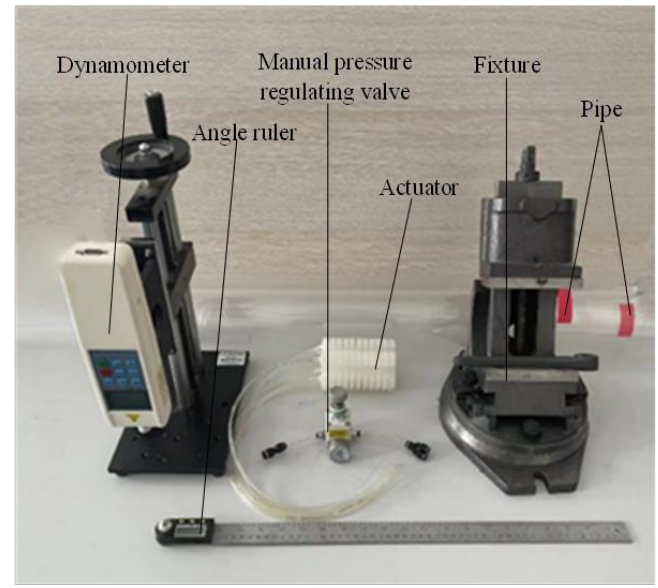
Figure 10. Experimental device diagram.